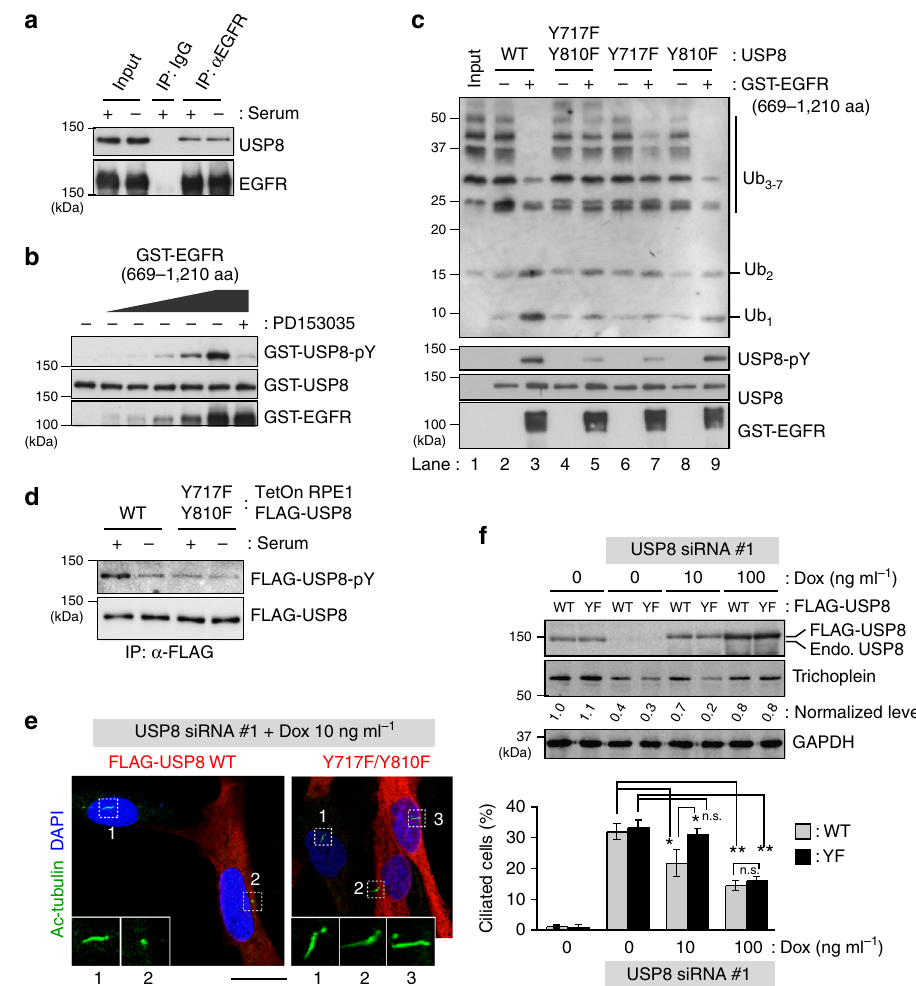
Fig. 7 EGFR directly phosphorylates USP8 on Tyr-717 and Tyr-810 to elevate its DUB activity. a Anti-EGFR immunoprecipitates from serum-fed (serum: + ) or -starved (serum: -) RPE1 cell lysates were analyzed by anti-USP8 and anti-EGFR immunoblotting. b Bacterially puri fi ed GST-USP8 was incubated with puri fi ed GST-EGFR (669 – 1210 aa) in the presence or absence of 1 μ M PD153035 for 15 min at 30 °C. c Bacterially puri fi ed non-tagged USP8 variants (WT, Y717F/Y810F, Y717F, and Y810F) were incubated with or without GST-EGFR (669 – 1210 aa) for 15 min at 30 °C, and then incubated with ubiquitin oligomers (Ub 3 – 7 ) for 15 min at 37 °C. d TetOn-RPE1 FLAG-USP8 (WT and Y717F/Y810F) cells treated with 10 ng ml − 1 of Dox (serum: + ) were subjected to 24 h serum starvation (serum: − ). Anti-pY and anti-FLAG immunoblotting of anti-FLAG immunoprecipitates are shown. e , f TetOn-RPE1 FLAG-USP8 (WT and Y717F/Y810F; YF) cells were transfected with control or USP8 siRNA (#1), and then cultured for 48 h in the presence of indicated concentration of Dox. Representative confocal images of acetylated-tubulin (green), FLAG (red) and DAPI (blue) are shown in e . Scale bar, 20 μ m. Normalized intensities of trichoplein/GAPDH are calculated by immunoblotting ( f ) and shown as mean from three independent biological replicates. Percentages of ciliated cell (mean ± SD from three independent experiments, n > 200 each) are shown in f . Normalized intensities of trichoplein/GAPDH are shown as mean from three independent biological replicates. ** p < 0.01, *0.01 < p < 0.05, n.s., not signi fi cant, two-tailed unpaired student ’ s t